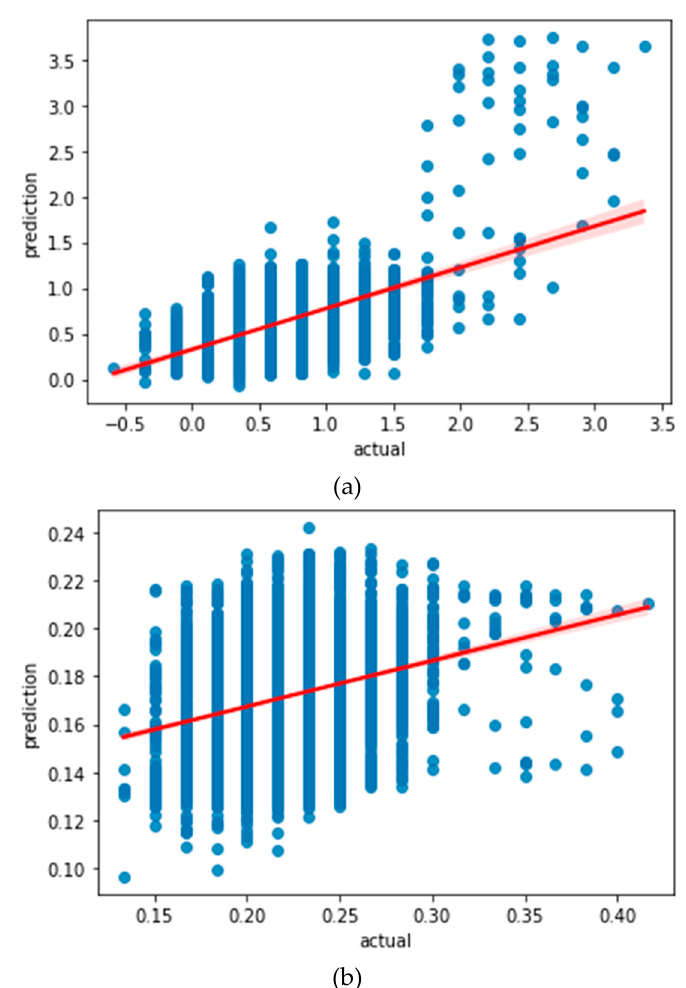
Figure 3. ( a ) Regression curve of LSTM learning model with standardization preprocessing; ( b ) regression curve of LSTM learning model with normalization preprocessing.